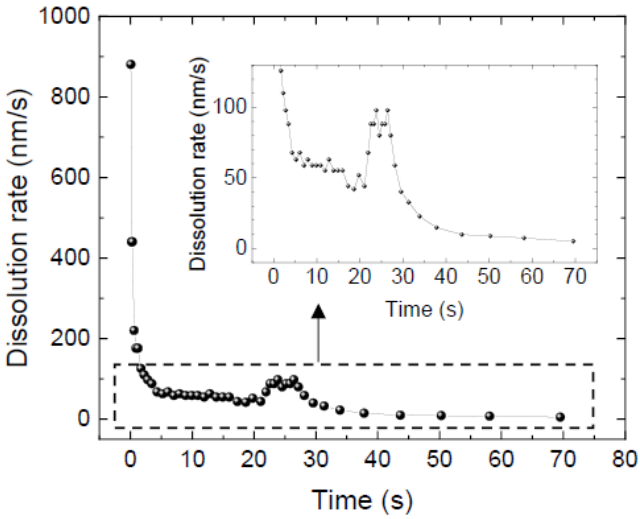
Figure 3. Time dependence of dissolution rate at the center of the pit. The same dissolution pit as in Figure 2 was analyzed.